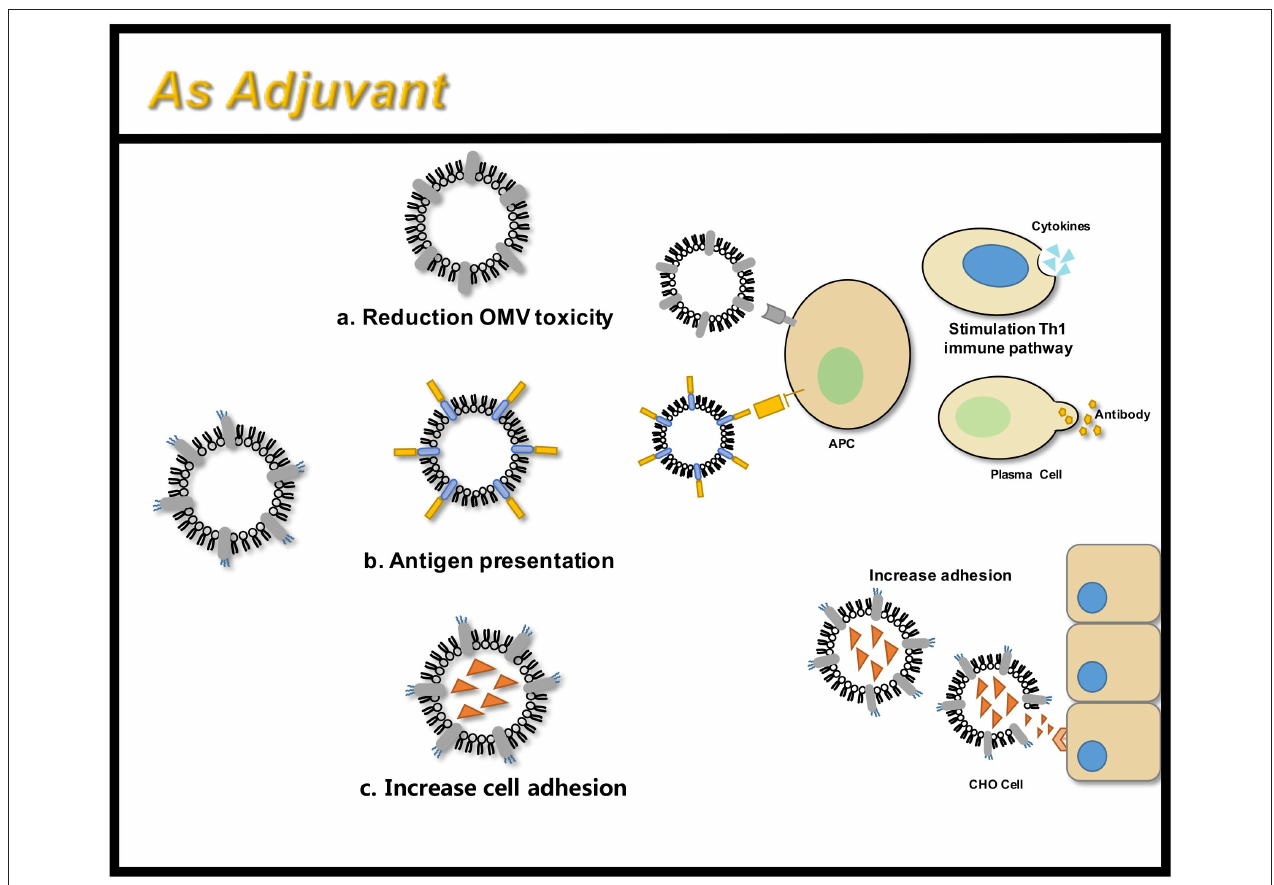
FIGURE 7 | OMVs function as an adjuvant through three main areas: (a) attenuated antigen stimulation; (b) presentation of heterologous antigens; (c) increased adhesion to tissue